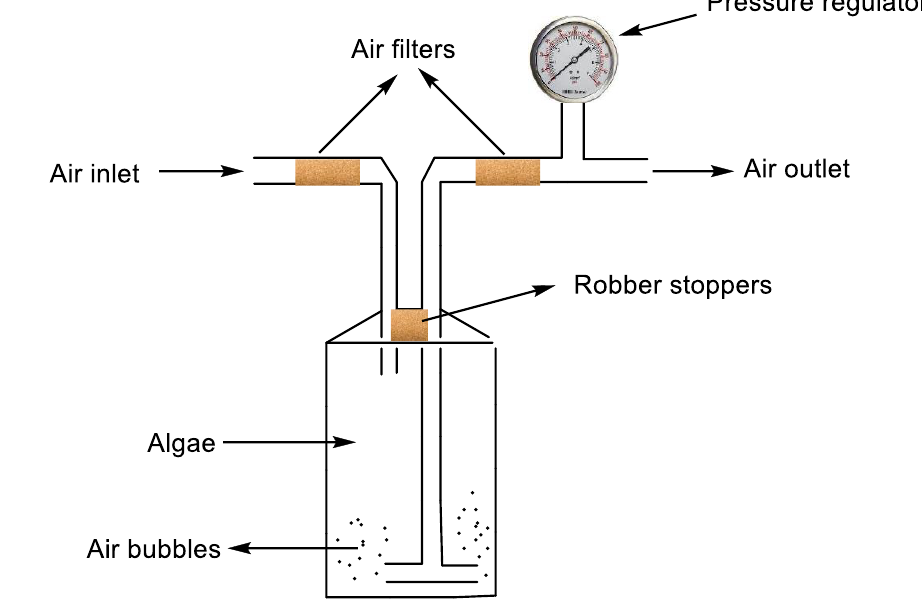
Figure 2. Laboratory-scale photobioreactor model for cultivating algae.